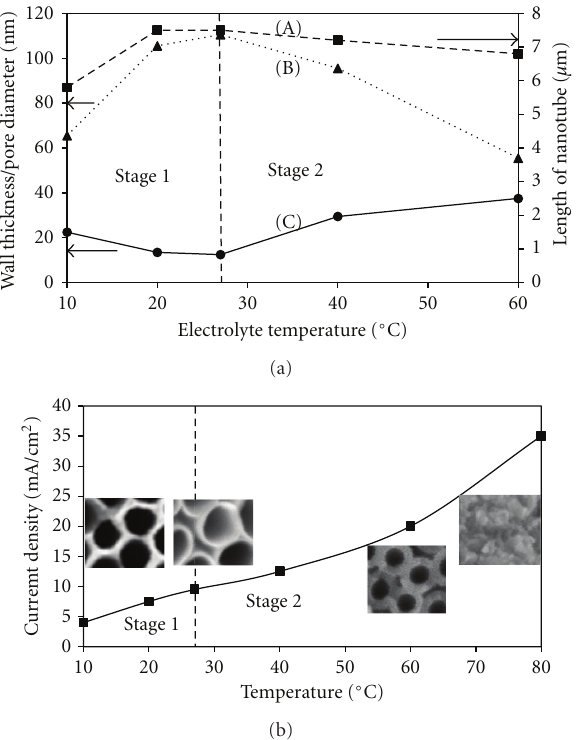
Figure 2: (a) E ff ect of anodization temperature on the (A) length, (B) pore diameter, and (C) wall thickness of the TiO 2 nanotube arrays anodized at 60 V for 1h; (b) current density as function of anodization temperature.